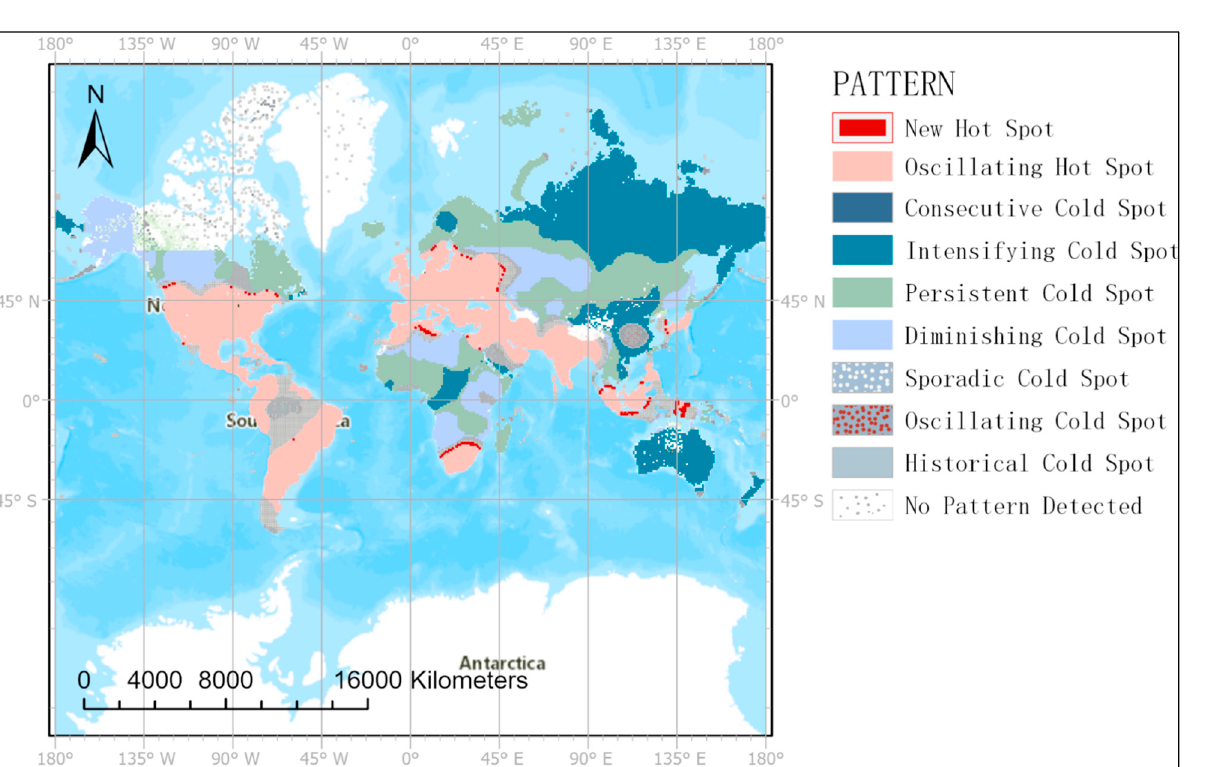
Figure 4. Cold and hot spot patterns of confirmed COVID-19